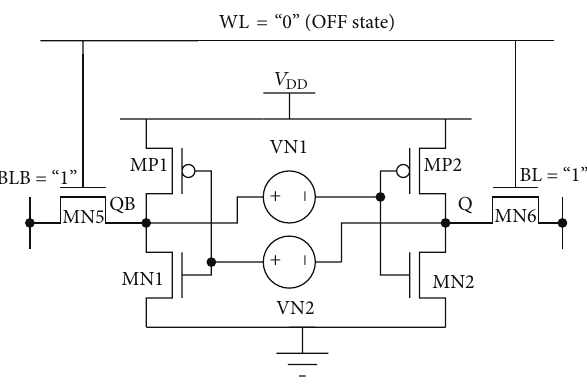
Figure 7: Test circuit for measurement of hold SNM of